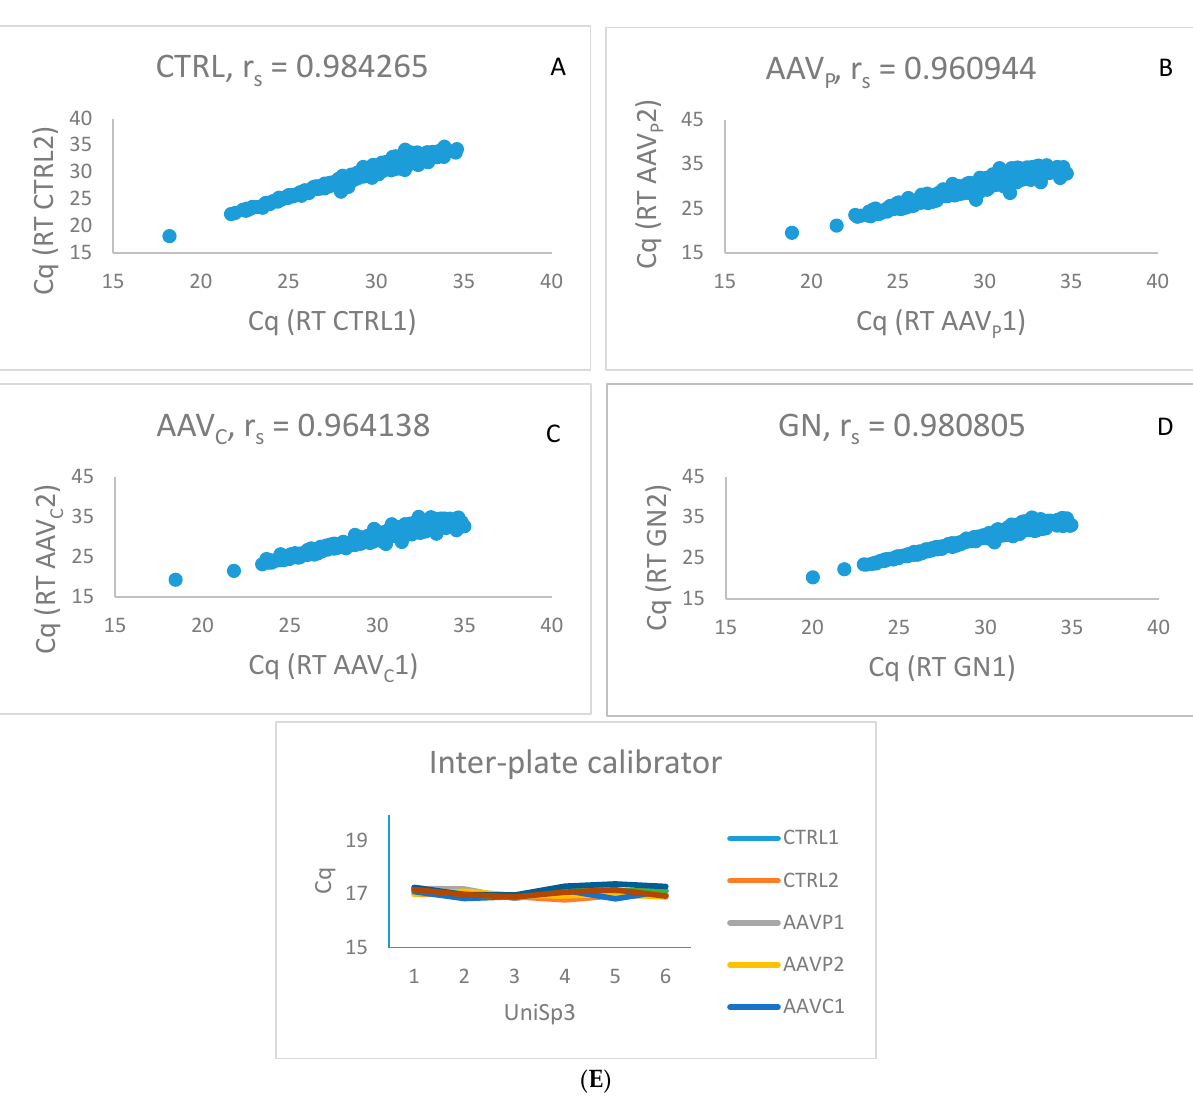
Figure 1. Quality control of the results of analysed sample pools. ( A – D ). Correlation of expressions of miRNAs between two pools of the same group of samples: ( A ) correlation between two pools of healthy controls (CTRL); ( B , C ) correlation between four pools of ANCA-associated vasculitis (AAV); ( D ) correlation between two pools of glomerulonephrites (GN); ( E ) Expression of inter-plate calibrators in analysed pools of samples. Six inter-plate calibrators were located on two miRNOME panels (miRNOME panel I in miRNOME panel II).